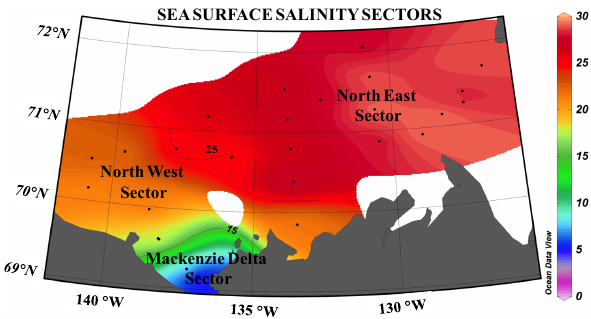
Fig. 2. Map of the sea surface salinity illustrating the different sur- Figure 2. Map of the sea surface salinity illustrating the different surface salinity sectors 722 face salinity sectors observed during the study: Mackenzie Delta observed during the study: Mackenzie Delta Sector (salinity < 15), North West Sector (15 < 723 Sector (salinity < 15), North West Sector (15 < salinity < 25) and salinity < 25) and North East Sector (salinity > 25). Isohalines 15 and 25 mark the boundaries 724 North East Sector (salinity > 25). Isohalines 15 and 25 mark the boundaries of these of these sectors . 725